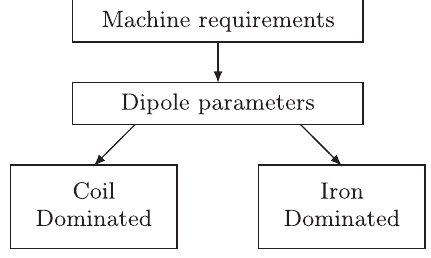
FIG. 2. Design options for dipole magnets.FIG. 1. Sketch of the ELENA ring.